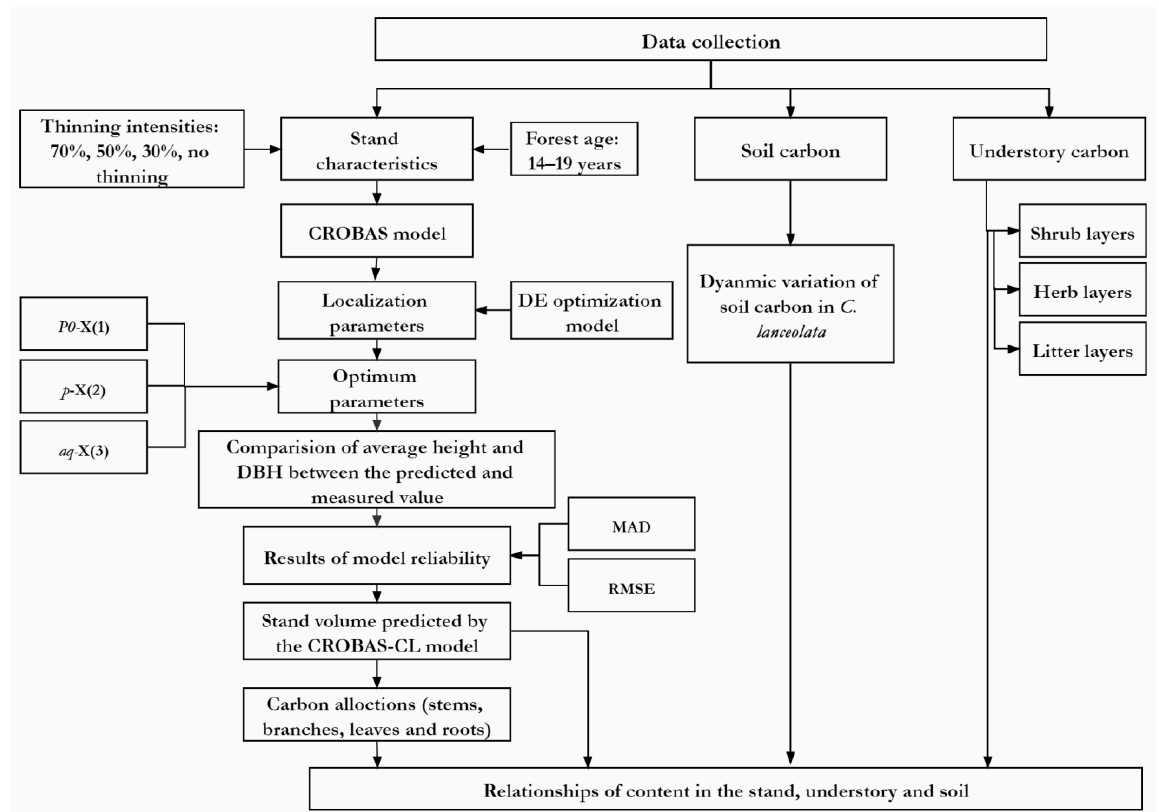
Figure 2. Flowchart of the process for exploring the effects of thinning on C. lanceolata carbon allocation.